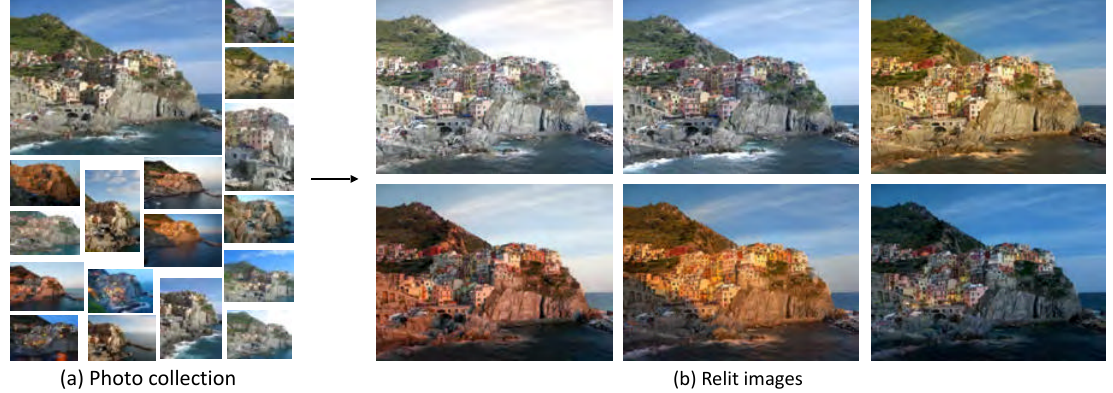
Fig. 1 Given a photo collection of a landmark scene under varying lighting, our method transfers the illumination between images from different viewpoints, synthesizing images with new combinations of viewpoint and